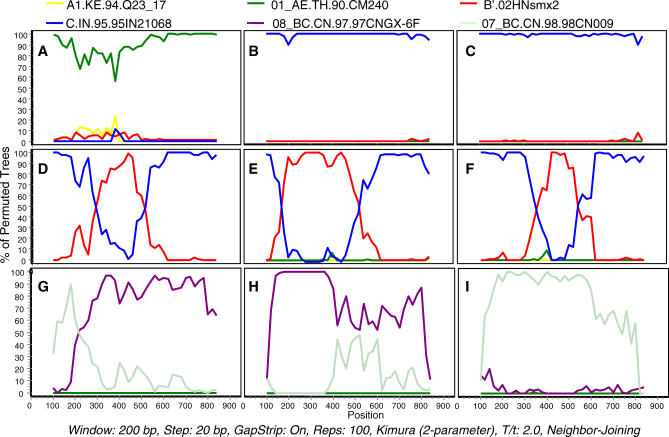
Bootscanning Analysis of HIV-1 RT Sequences of Six Study ParticipantsParticipants included one CRF01_AE virus 03YN.DH.rlE32 (A), two pure subtype C viruses 03YN.DH.mdC9 (B) and 03YN.DH.lxG9 (C), one new BC recombinant virus 03YN.DH.rlG29 (D and G), one CRF08_BC virus 03YN.HH.gjN165 (E and H), and one CRF07_BC virus 03YN.HH.gjN156 (F and I).The reference sequences obtained from the NIH/NIAID–funded HIV Databases are color-coded and shown on the top. The conditions used for this analysis are shown at the bottom. The boostrap values are based on 100 replicates using the neighbor-joining method.